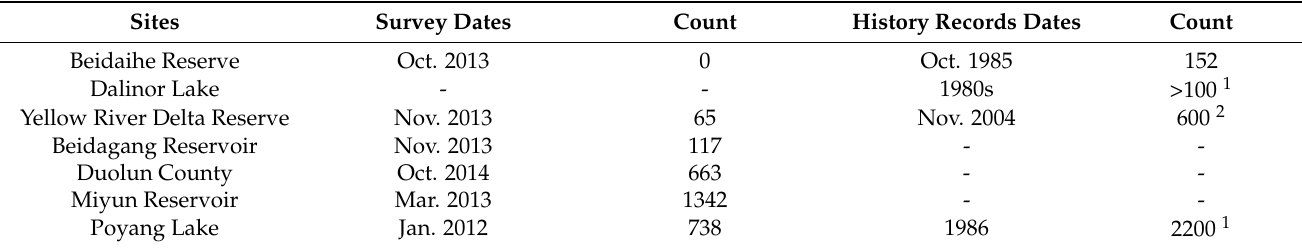
Table 2. The highest count of white-naped crane (2012–2016) in different sites (Figure 1).